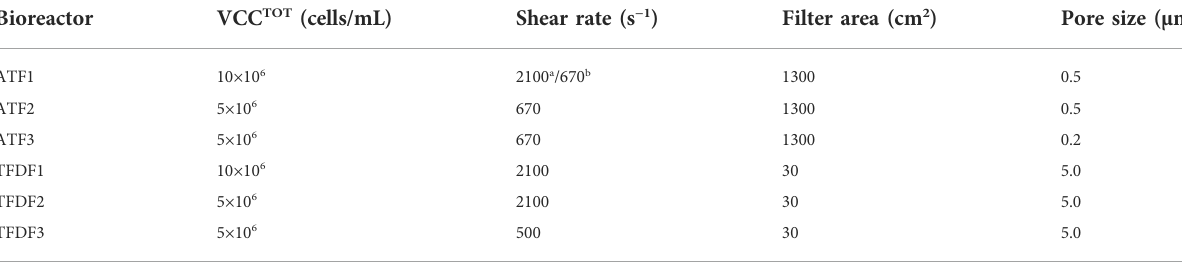
TABLE 1 Parameters used in the ATF and TFDF runs